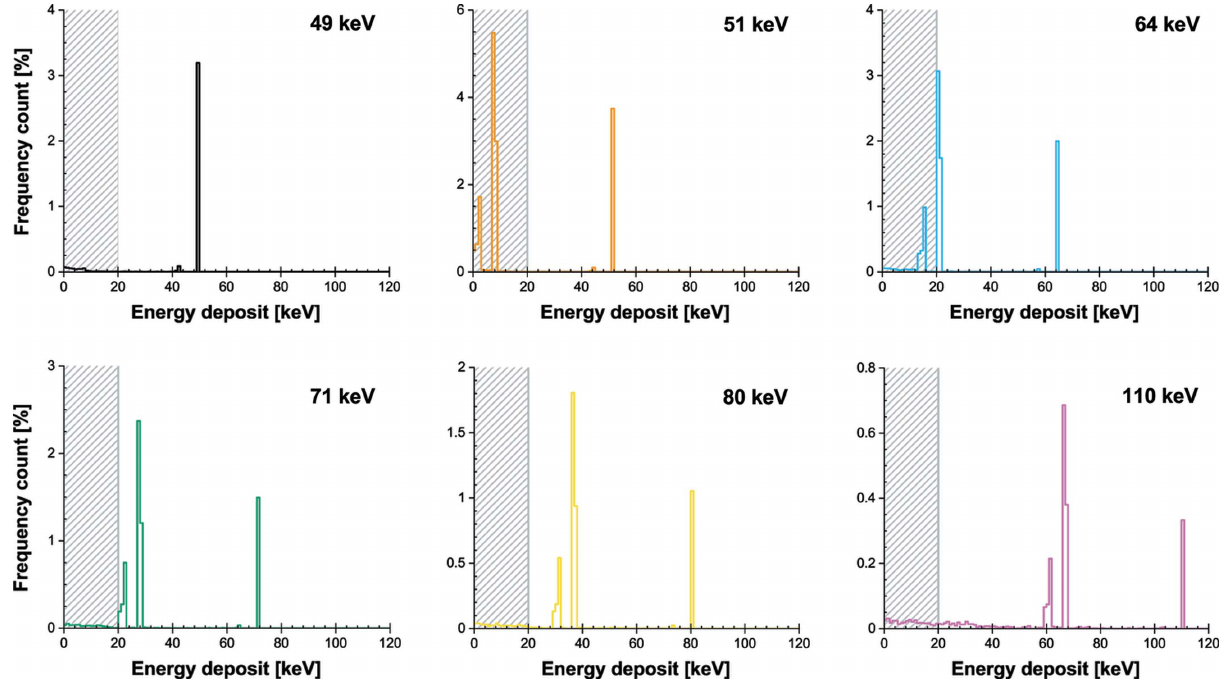
Figure 18 Distribution of energy deposits as a function of X-ray energy for 29 m m-thick GOS:Tb based on Geant4 simulations (100000 events). To exclude out-of- pixel interactions due to fluorescence from the gadolinium as well as Compton scattering, the interaction region is limited to 50 m m (cid:2) 50 m